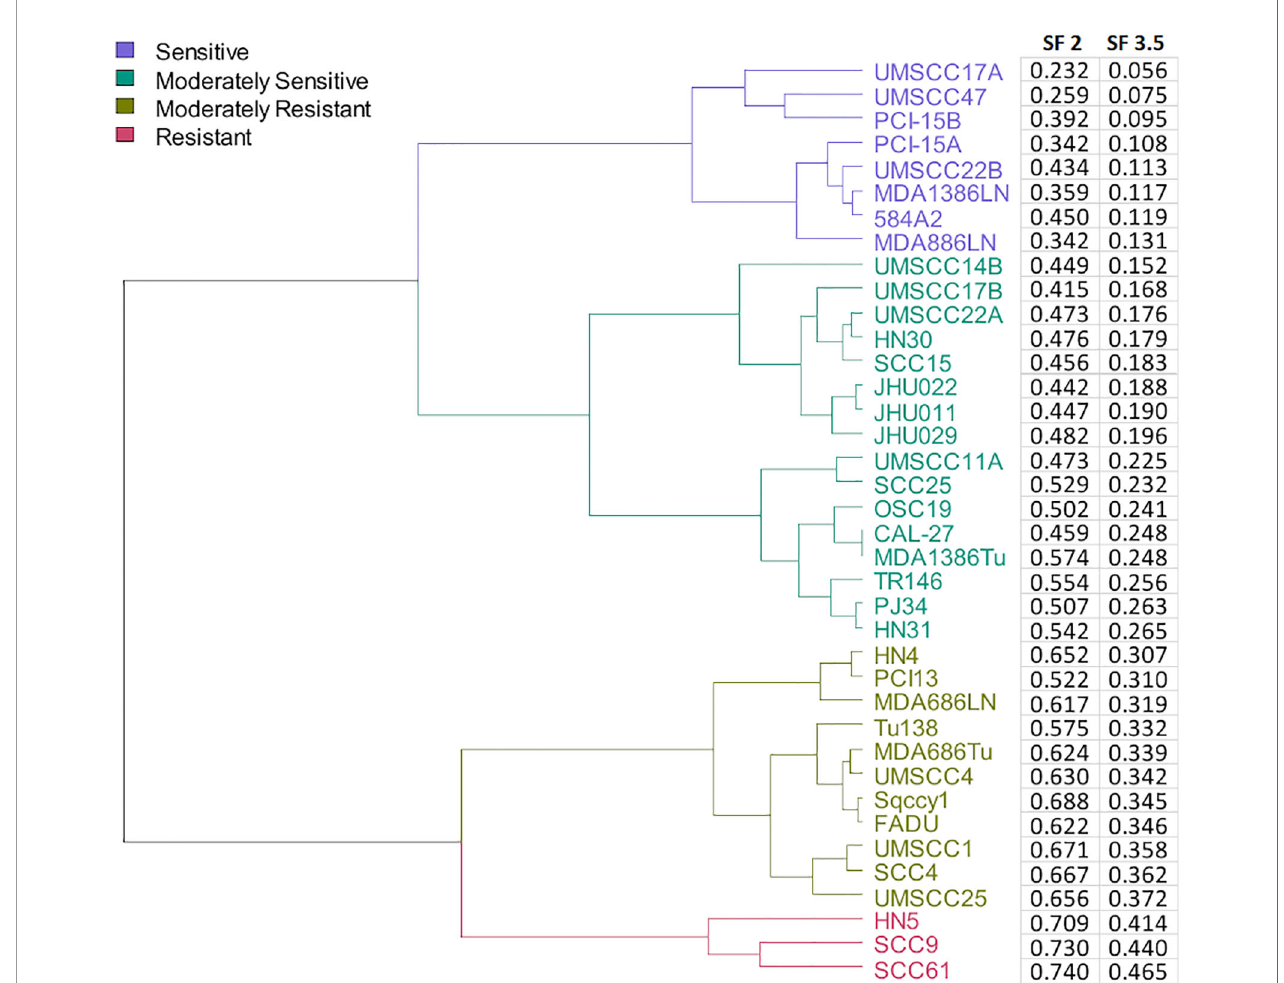
FIGURE 1 | Dendrogram of cell lines clustered by their radiosensitivity at 3.5 Gy and agnostically grouped into 4 clusters based upon